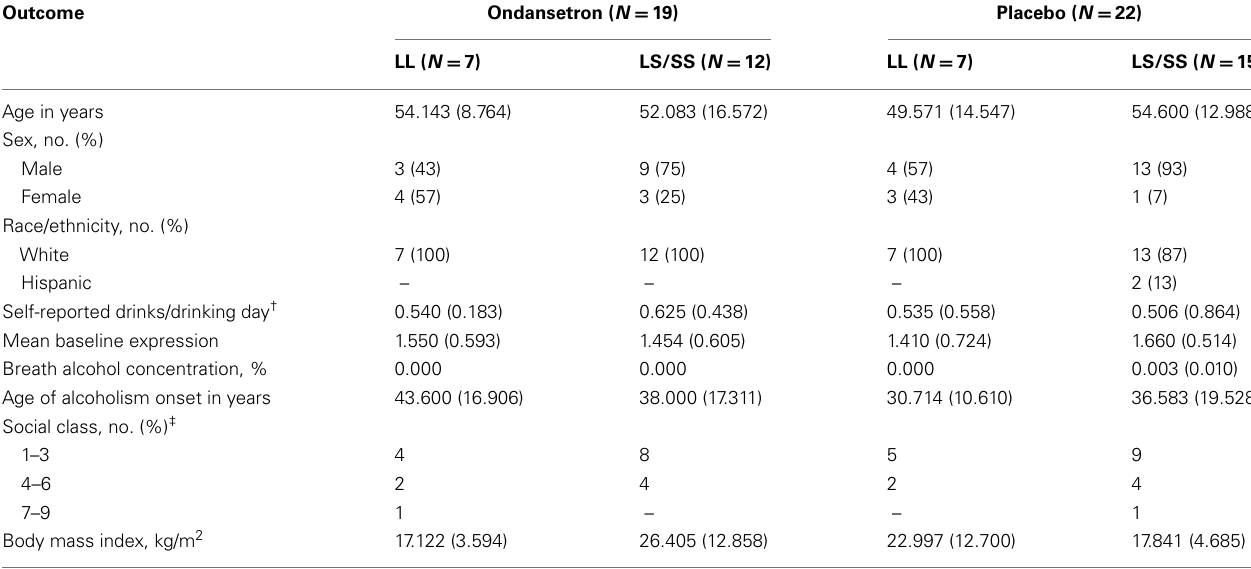
Table 1 | Baseline demographic and biological